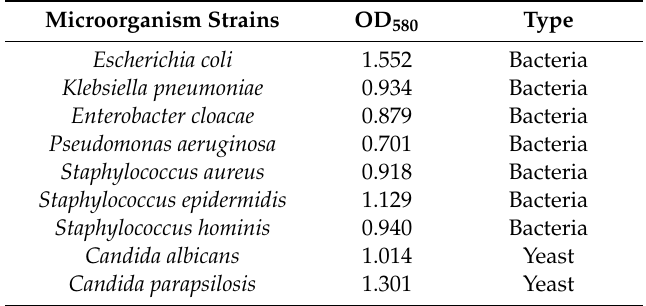
Table 4. Biofilm values obtained by crystal violet elution of each microorganism analyzed in this study. OD 580 (optical density at 580